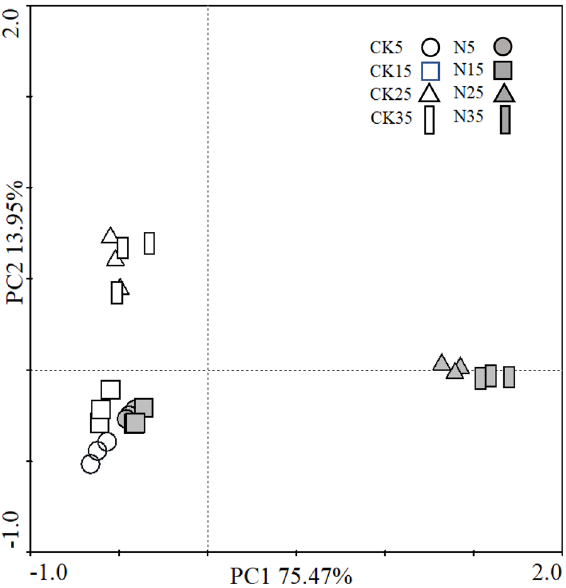
Figure 4. Principal coordinate analysis (PCoA) of the bacterial community structure at different incubation temperatures. Different symbols represent samples under different incubation temperatures. CK, soil samples with no N application; N, soil samples with N application.